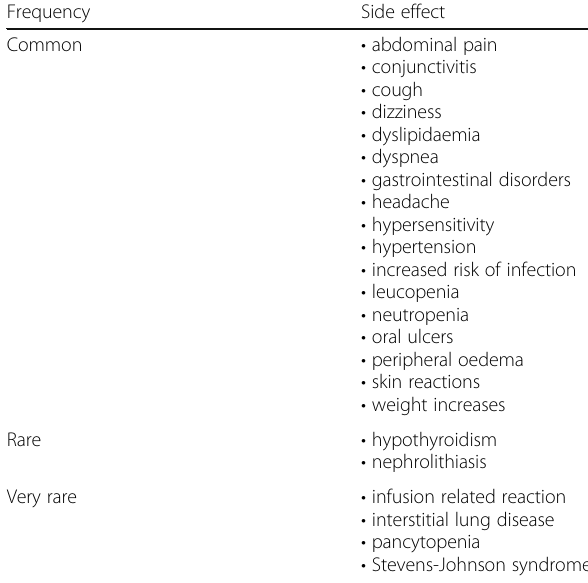
Table 1 Side effect profile for Tocilizumab